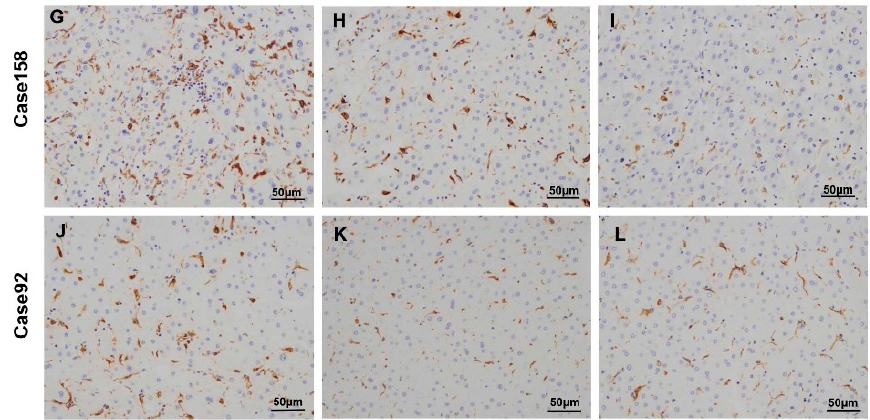
Figure 1. Representative immunostaining images of CD68 ( A , D , G , J ); CD86 ( B , E , H , K ); and CD206 ( C , F , I , L ) in HCC tissue microarray sections were shown. Case 17 ( A – C ) showed low staining presence of CD68 + , CD86 + and CD206 + macrophages; Case 32 ( D – F ) showed high staining presence of CD68 + , CD86 + and CD206 + macrophages; Case 158 ( G – I ) showed high staining presence of CD68 + and CD86 + macrophages, but low staining presence of CD206 + macrophages; Case 92 ( J – L ) showed high staining presence of CD68 + and CD206 + macrophages, but low staining presence of CD86 + macrophages.